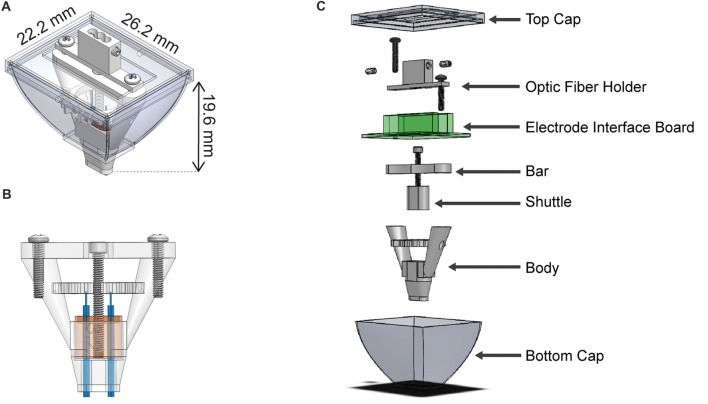
Schematic representation of the hybrid-drive combining optogenetics, pharmacology and electrophysiology (HOPE). (A) Outer view with dimensions. (B) Section view showing the drive mechanism used to move the shuttle. (C) Exploded view of the implant with all individual parts.